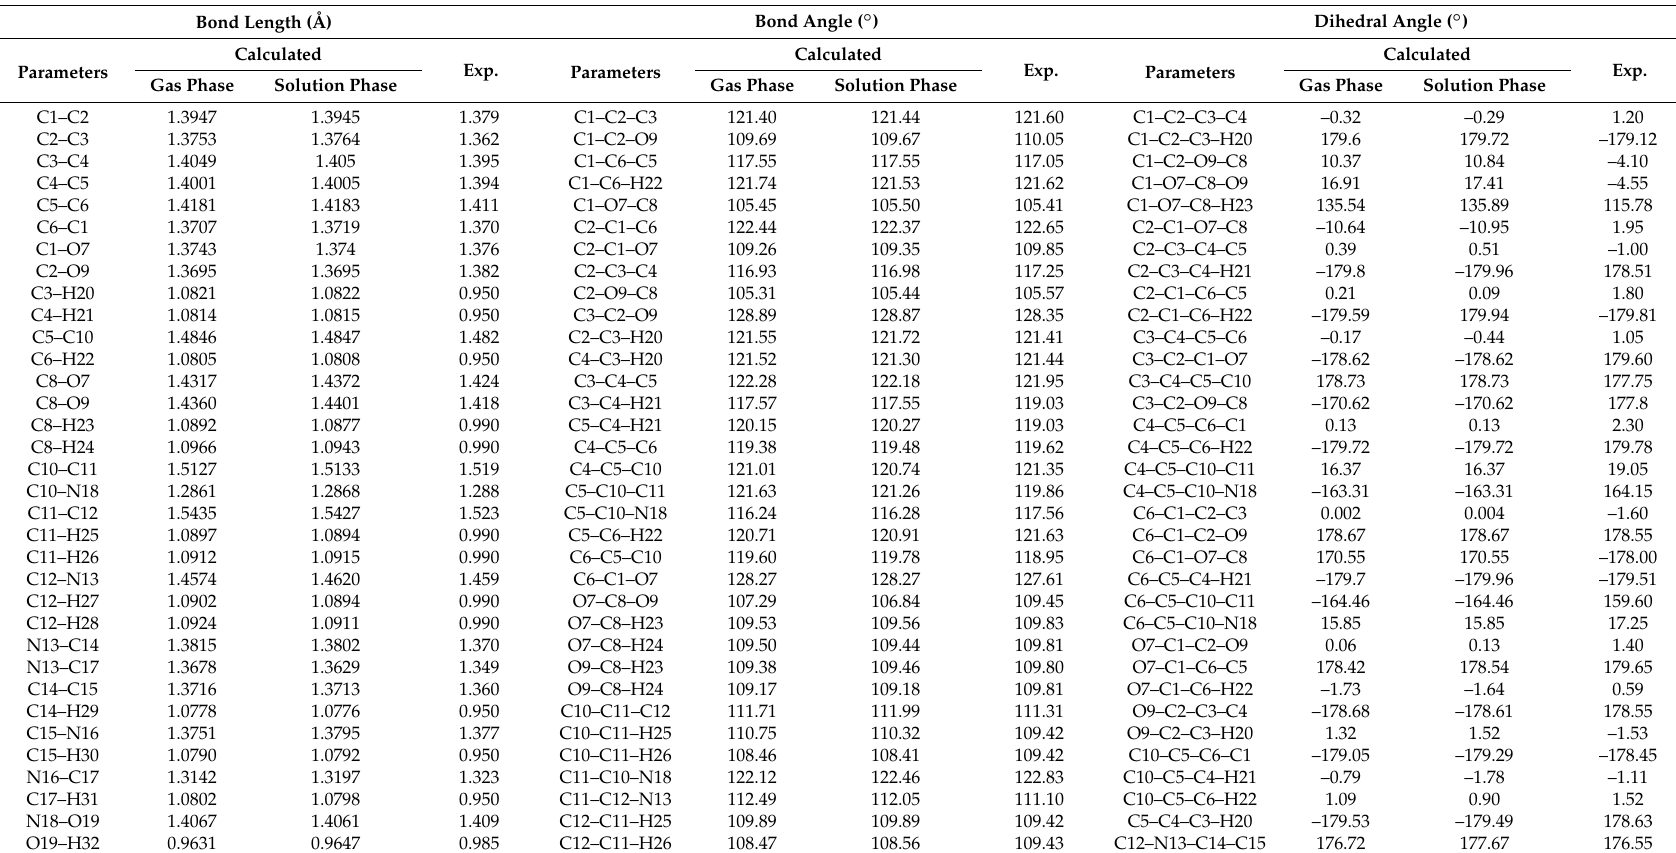
Table 2. Optimized structural geometry parameters for compound 4